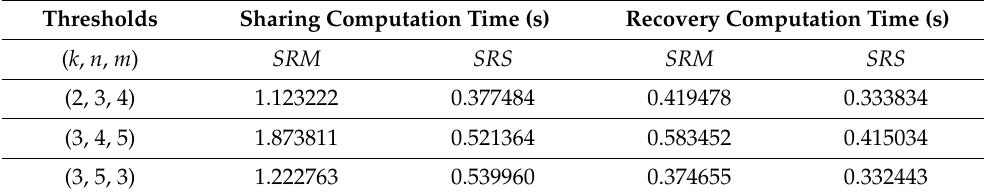
Figure 9. Results of the second proposed (3, 4, 5) SRS method. ( a – e ): 5 secret images with size 256 × 256; ( f – g ): 2 shared images with size 256 × 768; ( h , i ): 2 shared images with size 256 × 1024; ( j – n ): 5 recovered secret images from ( f – h ); ( o – s ): 5 recovered secret images from ( g , i ). Table 1. Performance of sharing and recovery procedures at different